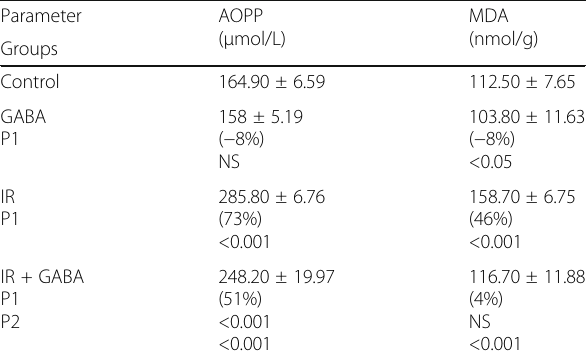
Table 3 Influence of GABA (200 mg/Kg b.wt; 3 weeks) on oxidant biomarkers values in jejunum of 6 Gy whole body gamma-irradiated